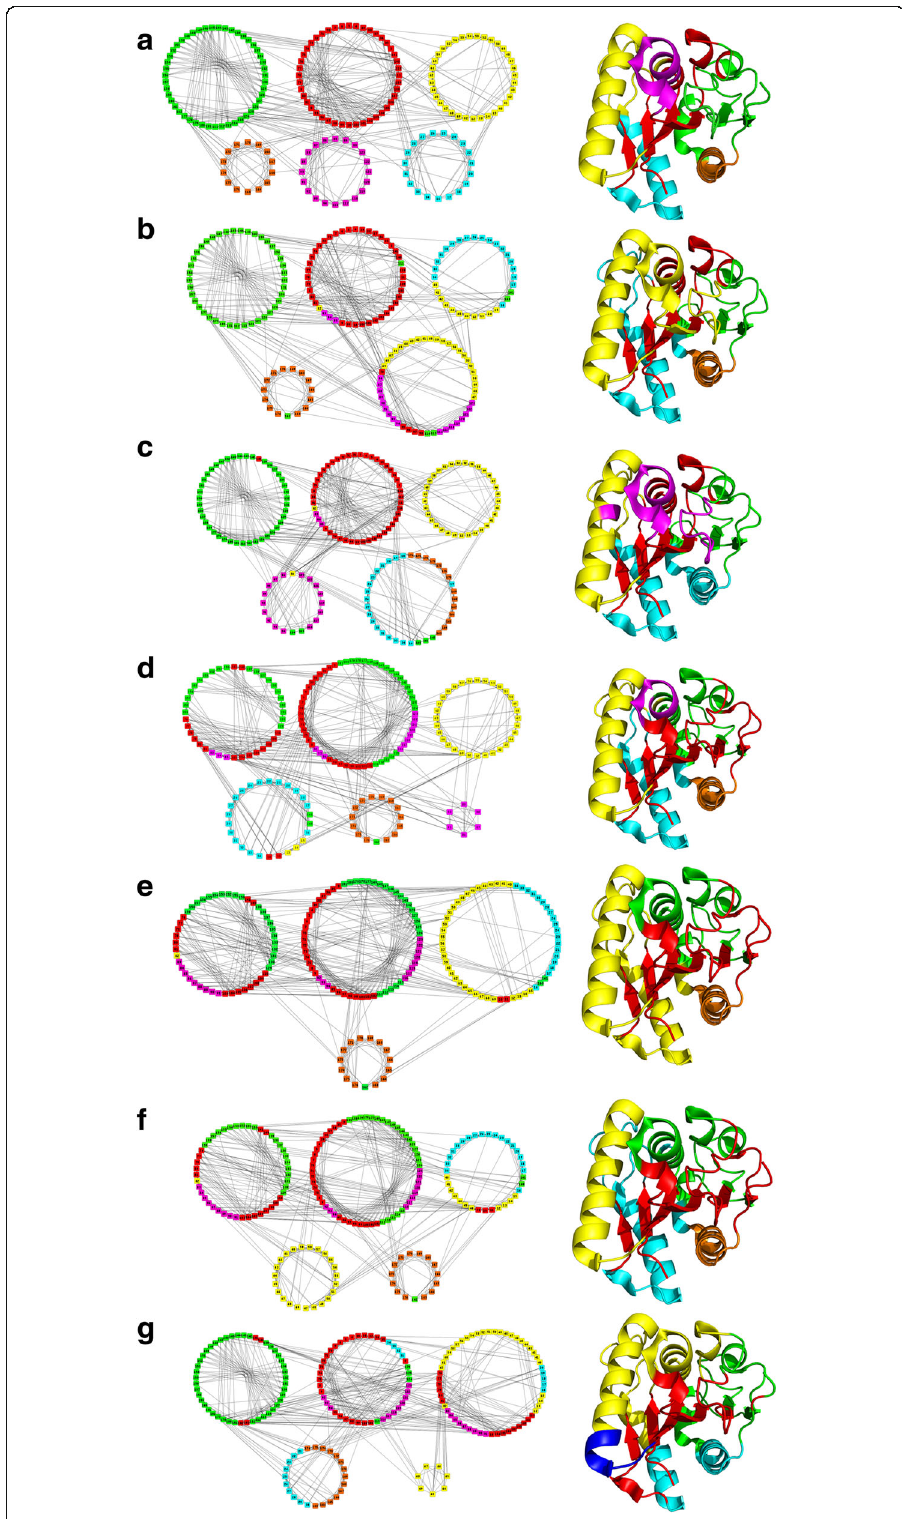
Fig. 7 Reorganisation of communities in WT and six mutant PCNs and their structures. Colour-coding is as per the WT modules. See text for